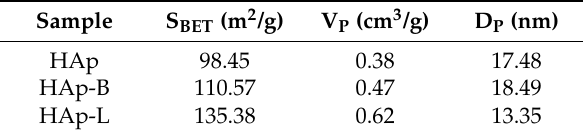
Table 1. Specific surface area S BET , pore volume V P , mean pore diameter D P .